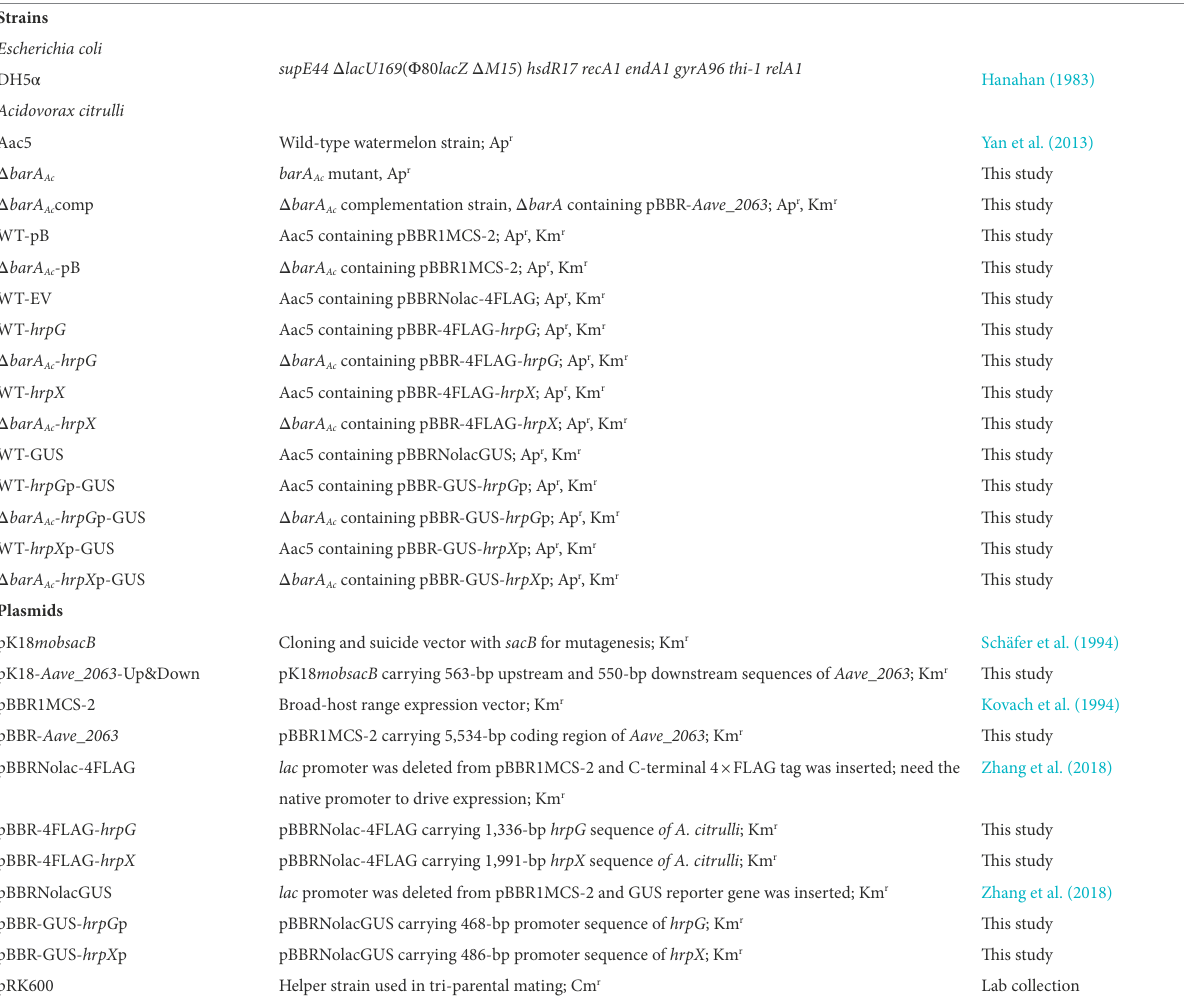
TABLE 1 Strains and plasmids used in this study. Strain or plasmid